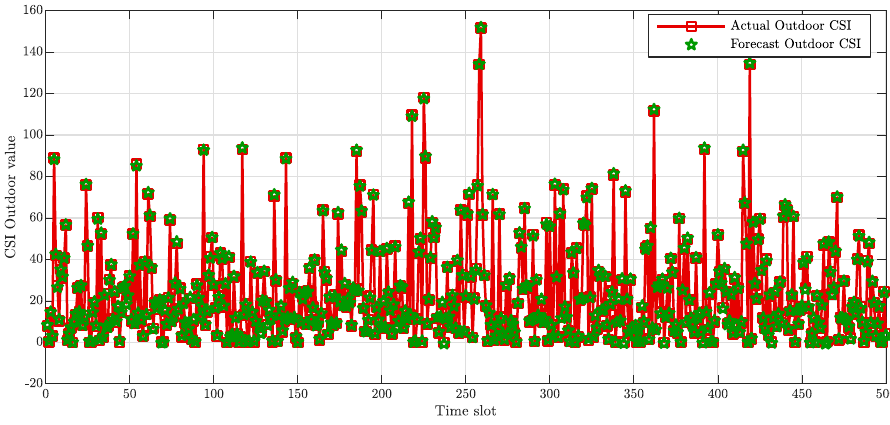
Figure 4. Outdoor CSI amplitude value comparison in